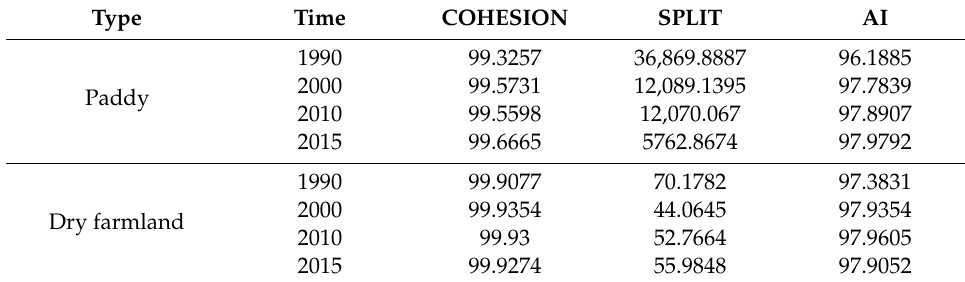
Table 3. The indices (COHESION, SPLIT, and AI) applied to describe the aggregation features of paddy and dry